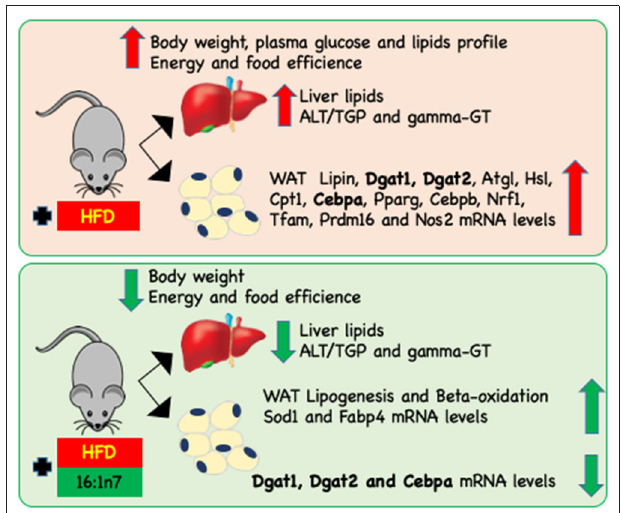
FIGURE 6 | Schematic representation of changes induced by HFD on the body, liver, and inguinal (ING) adipose depot attenuated by 16:1n7 supplementation. HF diet led to increasing of body weight, food and energy efficiency, plasma glucose, triglyceride, total cholesterol and fractions, ALT/TGP and γ -GT, liver TAG, and total cholesterol levels, as well as lipin , Dgat1 , Dgat2 , Atgl , Hsl , Cpt1 , Cebpa , Pparg , Cebpb , Nrf1 , Tfam , Prdm16 , and Nos2 mRNA levels in ING WAT. Treatment with 16:1n7 for 28 days reversed many of these effects. Additionally, 16:1n7 increased ING adipocytes lipogenesis and β -oxidation of fatty acids, and increased Sod1 and Fabp4 mRNA